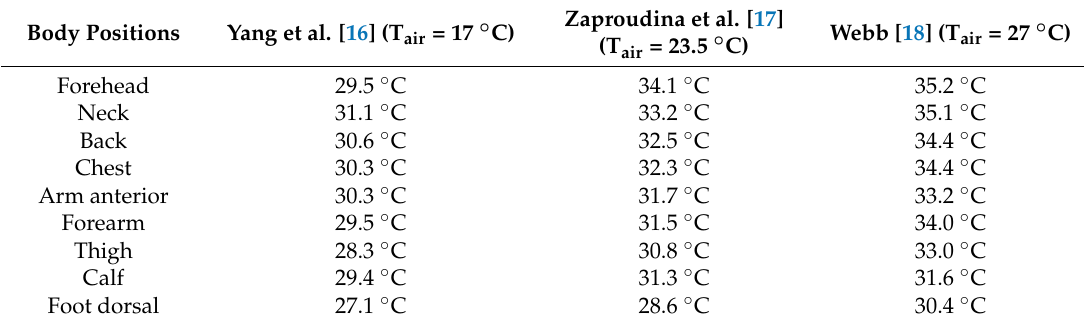
Table 1. Skin temperature for different body